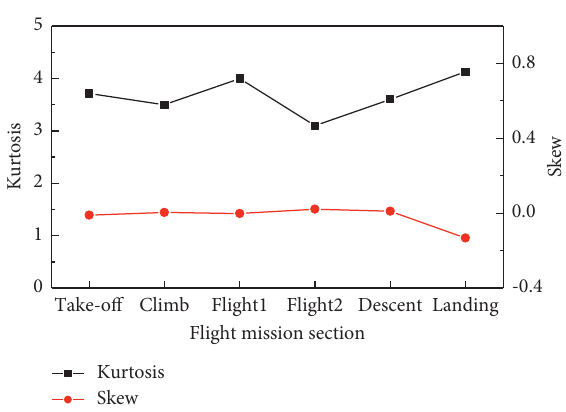
Figure 5: Kurtosis and skewness of the input acceleration excitation.